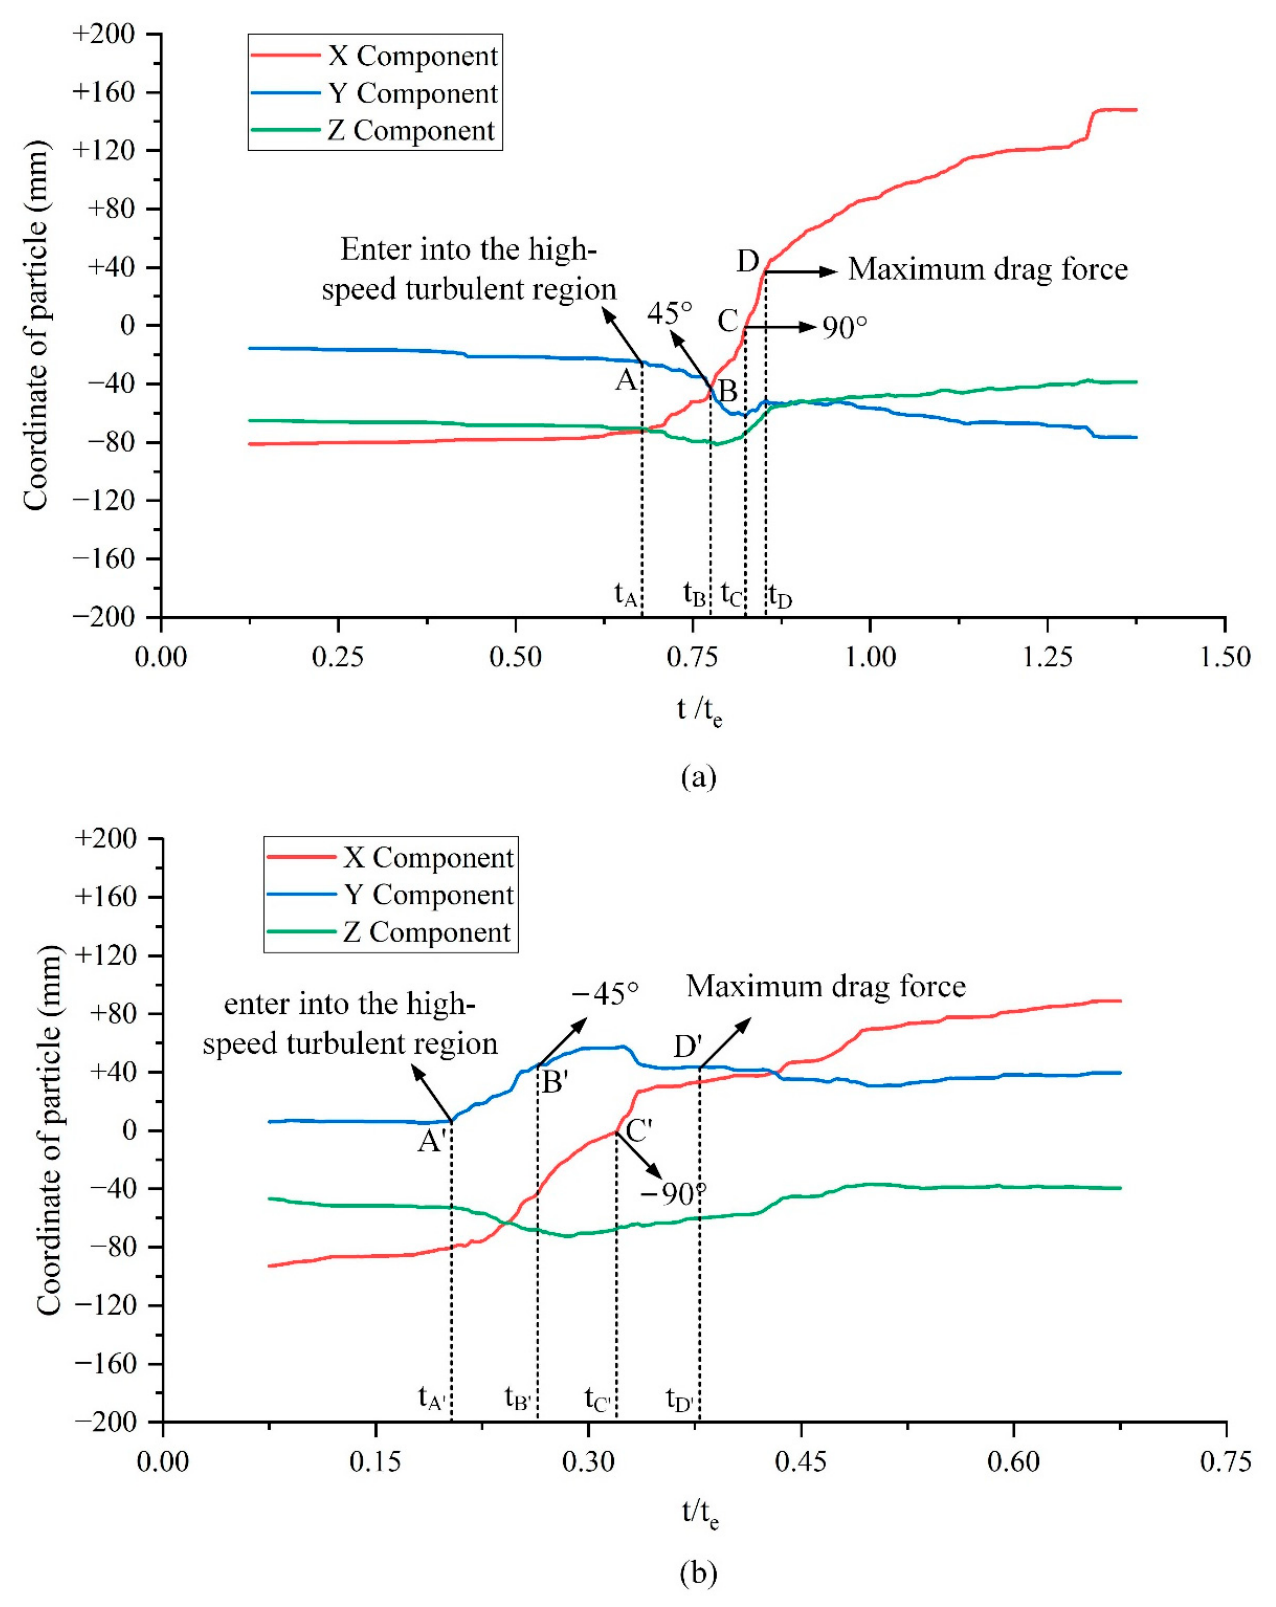
Figure 17. Coordinate time history of particles: ( a ) particle 1 and ( b ) particle 2.